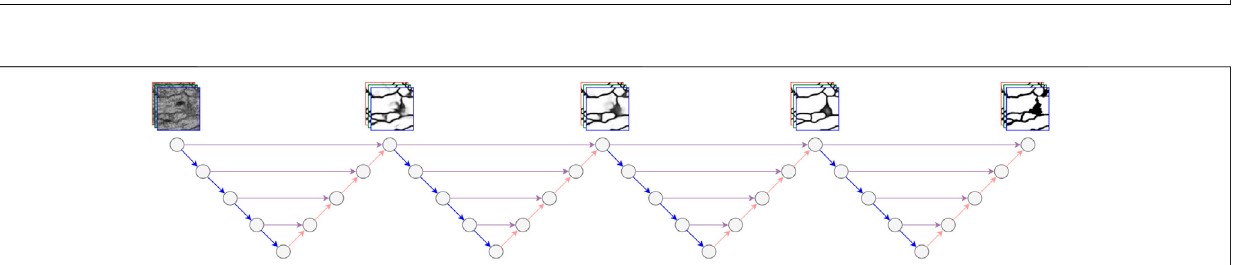
Frontiers in Computer Science |